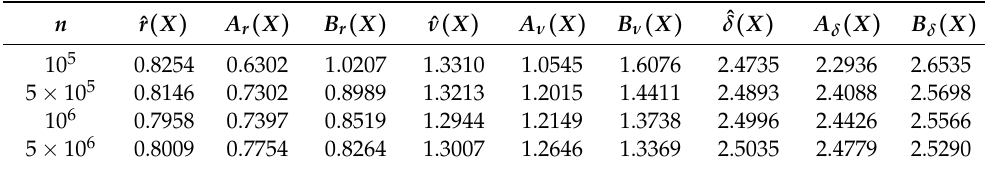
Table 6. Examples of estimates for the parameters and boundaries of confidence intervals for a model distribution GE ( 0.8;1.3;0.3;1.4;2.5 ) .